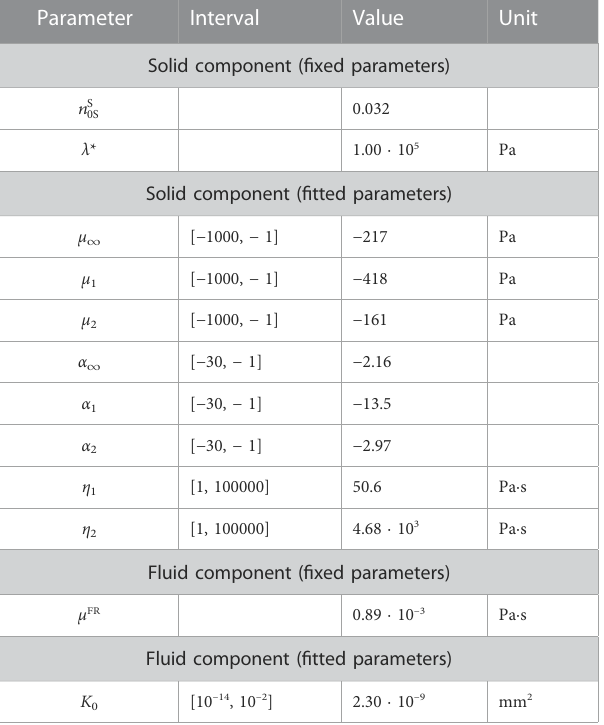
TABLE 1 Poro-viscoelastic material parameters for the composite hydrogel. The initial solid volume fraction n 0 S (cid:1) 1 − ∖ φ was estimated experimentally (see Figure 5 and Section 2.4), while the fi rst Lamé parameter λ * was set to a reasonablyhighvaluethatensuredsolidquasi-incompressibility.Theeffective shear viscosity μ FR corresponds to that of water at room temperature. Our inverse parameter identi fi cation (see Section 2.9) varies the parameters in givenintervalsand fi nallyprovidesanoptimalsetofallremainingparameters.